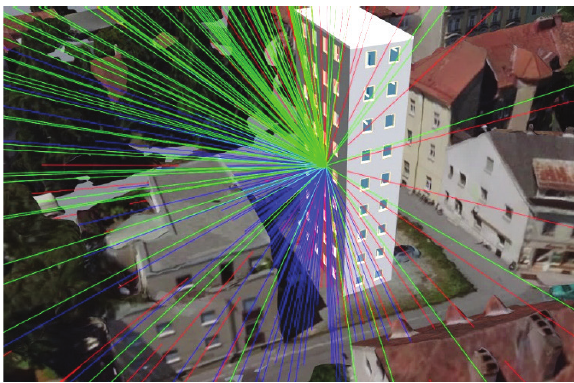
Figure 5. Performing wind ow visibility analysis using the QUVIAS method Table 2. Comparative analy sis of step angles from one